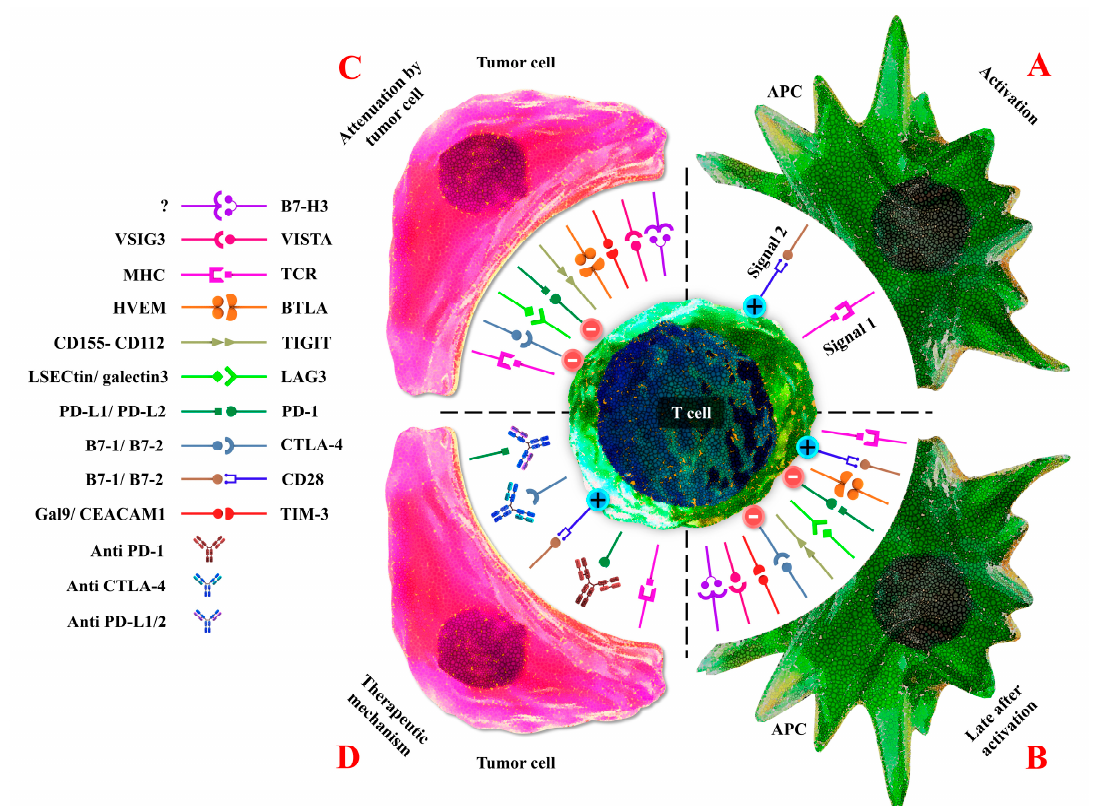
Figure 1. Mechanisms of ICIs. ( A ) Activation of T cells following two signals, the first interaction between TCR and MHC and the second, co-stimulatory signals (CD28 and B7-1/B7-2). ( B ) Expression of ICIs and interaction with their respective ligands to maintain immune homeostasis. ( C ) Cancer cells express increased inhibitory ligands to bind coinhibitory receptors on T-cells that lead to immune suppression. ( D ) mAbs that block ICIs such as CTLA-4, PD-1, PD-L1 restore T-cells effector function. (Abbreviations: ICI: Immune checkpoint inhibitors, TCR: T-cell receptor, MHC: Major histocompatibility complex, mAb: Monoclonal antibody, CTLA-4: Cytotoxic T-lymphocyte-associated protein 4, PD-1: Programmed cell death protein 1, PD-L1: Programmed death-ligand 1).